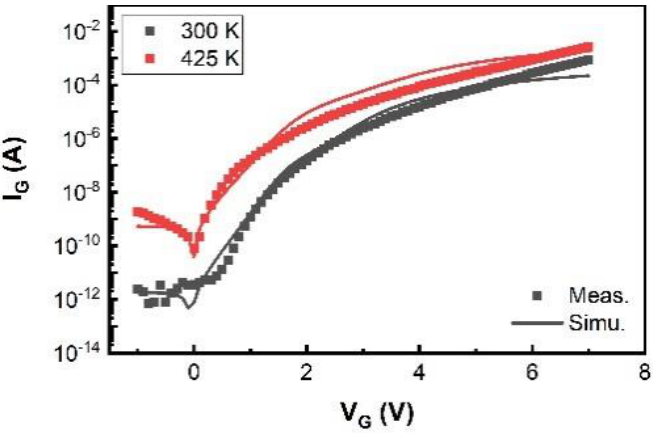
Figure 7. Measurement (dots) and simulation (lines) data of I G at 300 and 425 K with V DS = 0.1 V. The simulated transfer and output characteristics match well with the measurement results at 300 K in Figures 3 and 4, sweeping V G from − 1 V to 6 V with V D from 0.1 V to 2.2 V in I D -V G , and V D from − 1 V to 10 V with V G from 2 V to 7 V in I D -V D . The OFF-state capacitances C GS , C GD , and C DS at V G = 0 V with V D from 0 V to 200 V, are nicely